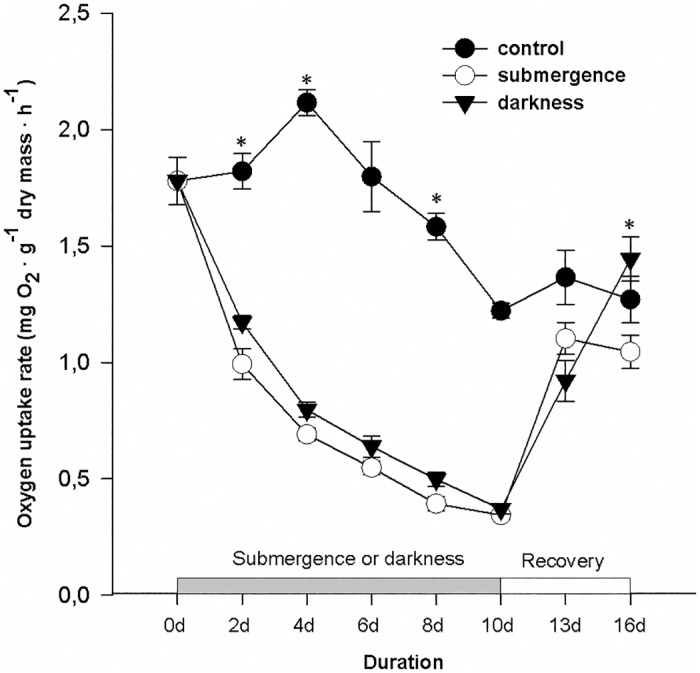
Respiration rate (mg O2 · g-1 dry mass · h-1) in entire individual A. philoxeroides plants.The plants were exposed to three different treatments for 10 days (0–10 d): 1) well drained and illuminated (control, black and closed circles), 2) submergence in darkness (white and open circles) or 3) non-submergence in darkness (triangles). From 10 d on, the plants were exposed to the normal growth conditions experienced by the control plants. The data are presented as the means ± SE, n = 5. For clarity, the statistical significance is shown only for the differences between the submergence/darkness and non-submergence/darkness at each sampling time. *, P < 0.05.